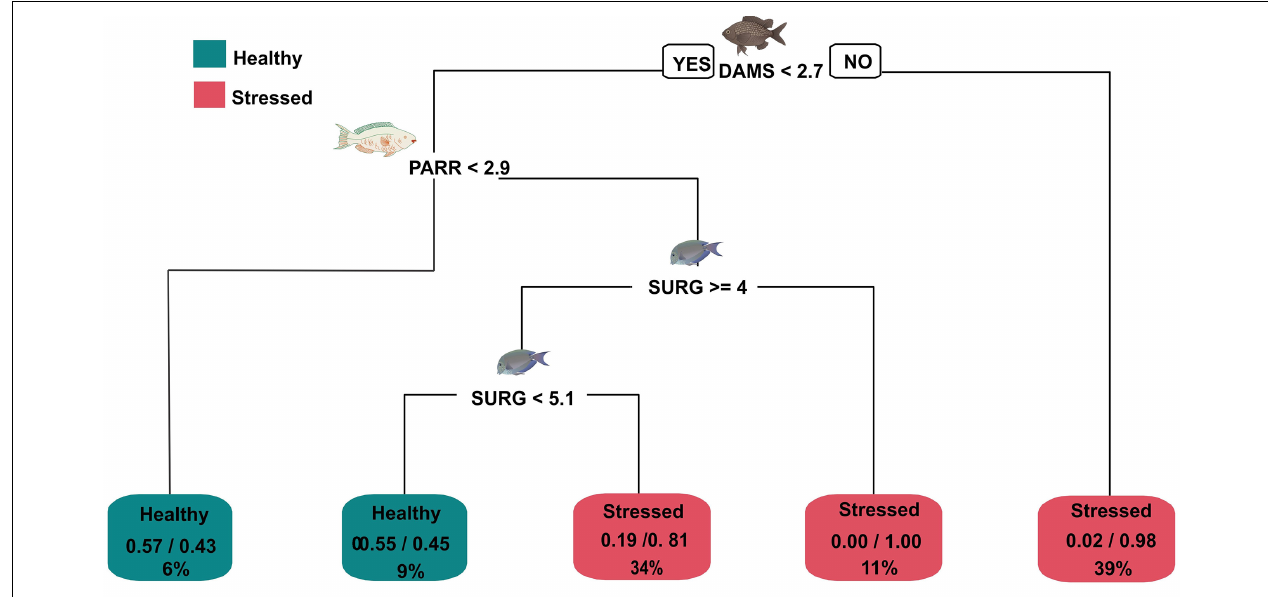
FIGURE 5 | Classification tree model to predict the coral state (coral or stressed) explained by key functional fish density (number of individuals per 100 m 2 ). DAMS, algal-gardening damselfish; PARR, parrotfish; SURG, surgeonfish. Numbers in the nodes correspond to fish density values when this condition is true, one must follow the left path of the classification tree model. The proportion between 0 and 1 in each rectangle correspond to the number of sites predicted in a coral state (left) and a stressed coral state (right) during the cross-validation. The percentage in the rectangle is the proportion of sites characterized by one of the states and the density fish conditions used in the construction of the classification model. The node error is 0.16, which means that 19/122 sites were not predicted in the state they really